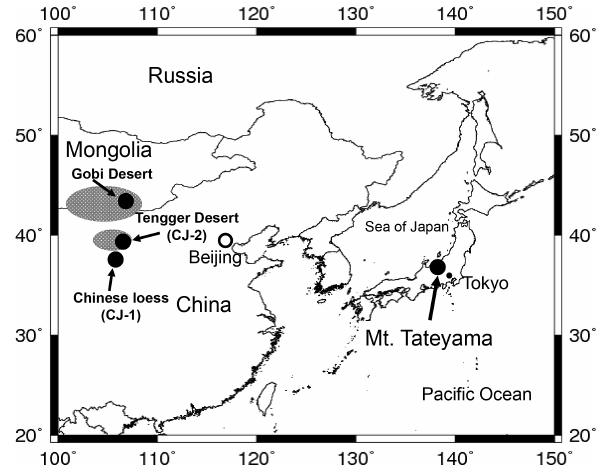
Figure 1. Location of the snowpack sampling site (Murodo-Daira) near Mt. Tateyama, central Japan. Sites are also shown for the loess deposit reference samples, which were collected from the Tengger and Gobi deserts in China and Mongolia (Nishikawa et al., 2000,